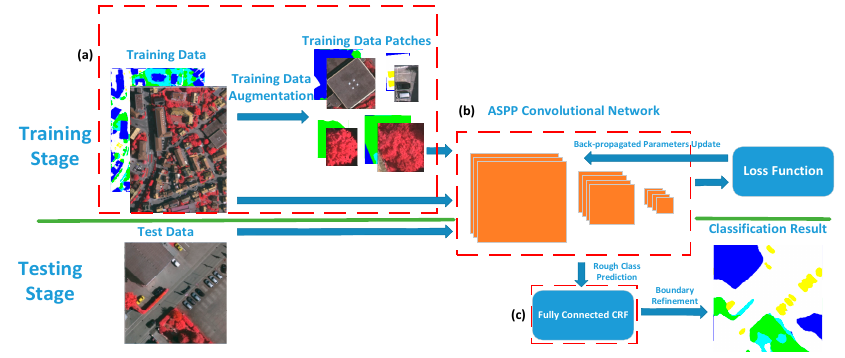
Figure 1. The workflow of our approach: The training stage and the testing stage are illustrated in the upper and lower parts, respectively. ( a ) Training data augmentation using pre-segmentation and selective search; ( b ) Image classification using an atrous spatial pyramid pooling (ASPP) network; ( c ) Post-processing using fully connected conditional random fields (CRFs).